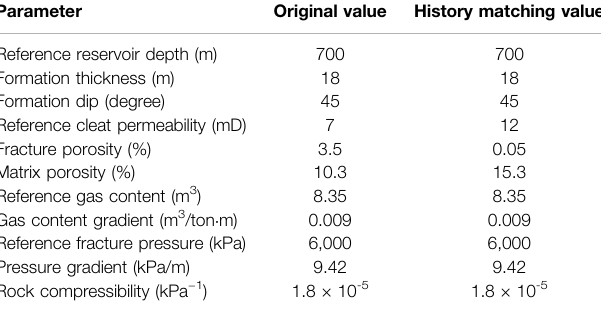
TABLE 2 | Original geological parameters and parameters after history matching. Parameter Original value